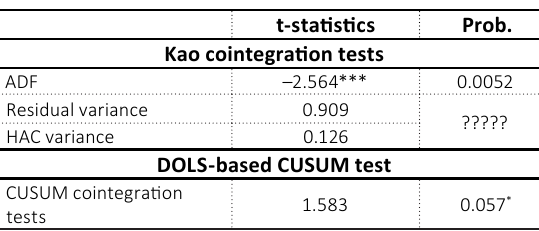
Table 8. The results of Kao and CUSUM